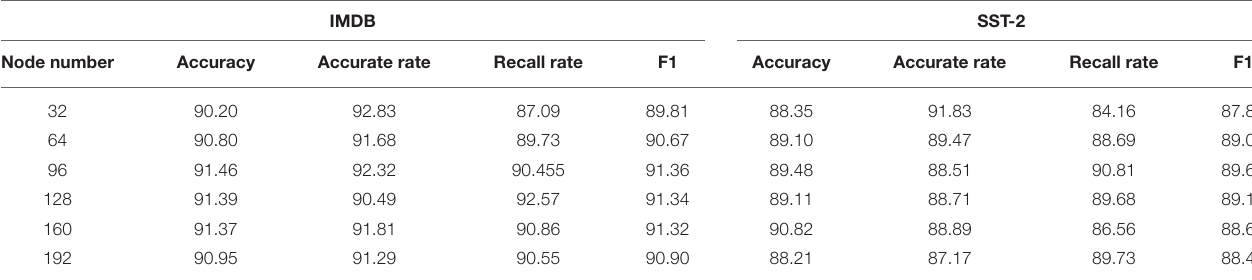
TABLE 4 | Experimental results of the different numbers of hidden layer